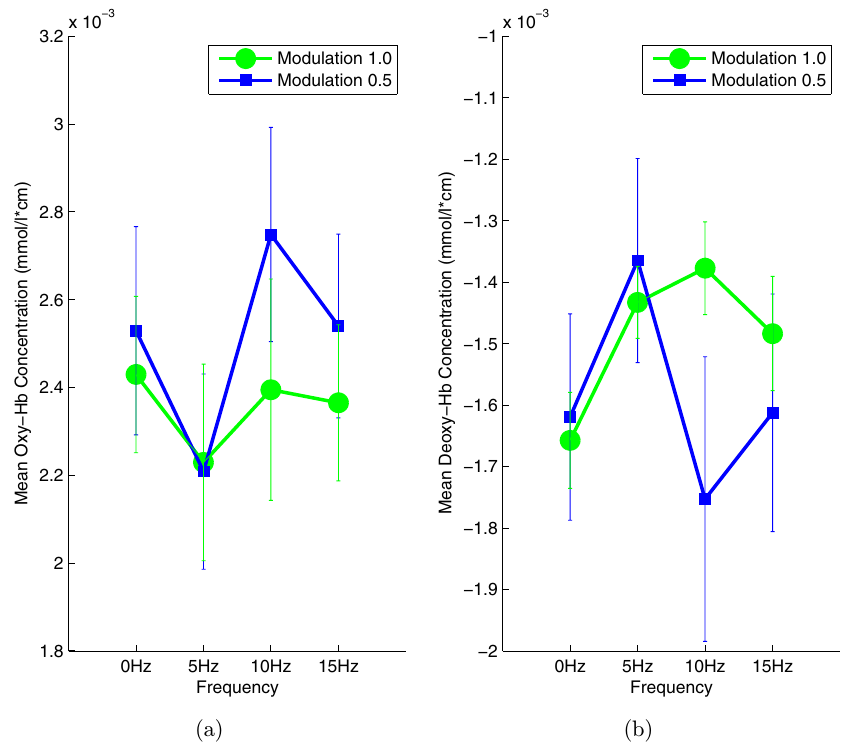
Fig. 10. Interaction of the modulation and frequency of °icking stimuli. (a) Oxy-Hb concentration and (b) Deoxy-Hb